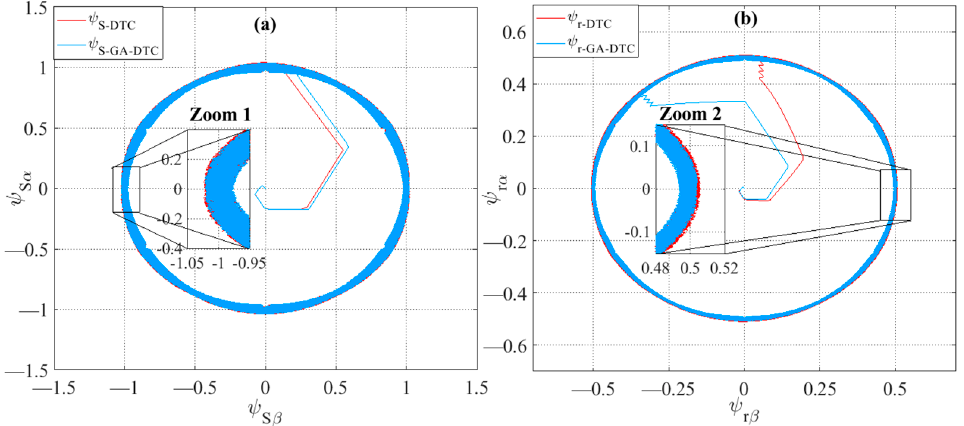
Figure 16. Stator ( a ) and rotor ( b ) fluxes of both strategies.